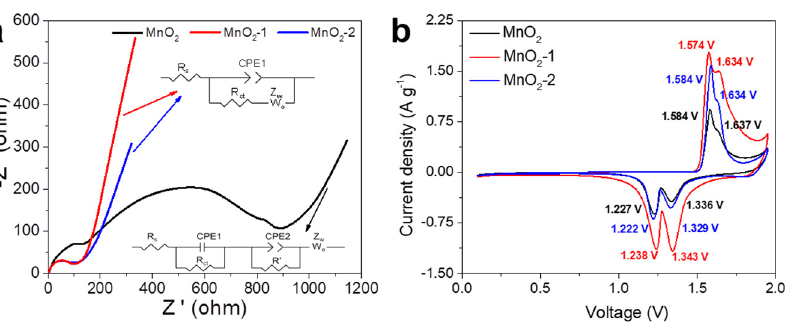
Figure 4. ( a ) Electrochemical impedance spectroscopy (EIS) spectra; and ( b ) cyclic voltammetry (CV) curves of the three batteries at a scan rate of 0.3 mV s − 1